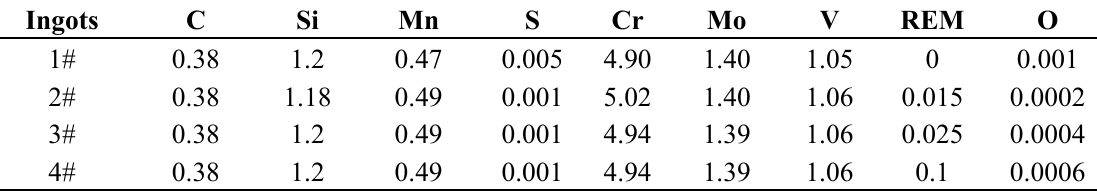
Table 1. The compositions of H13 steel ingots